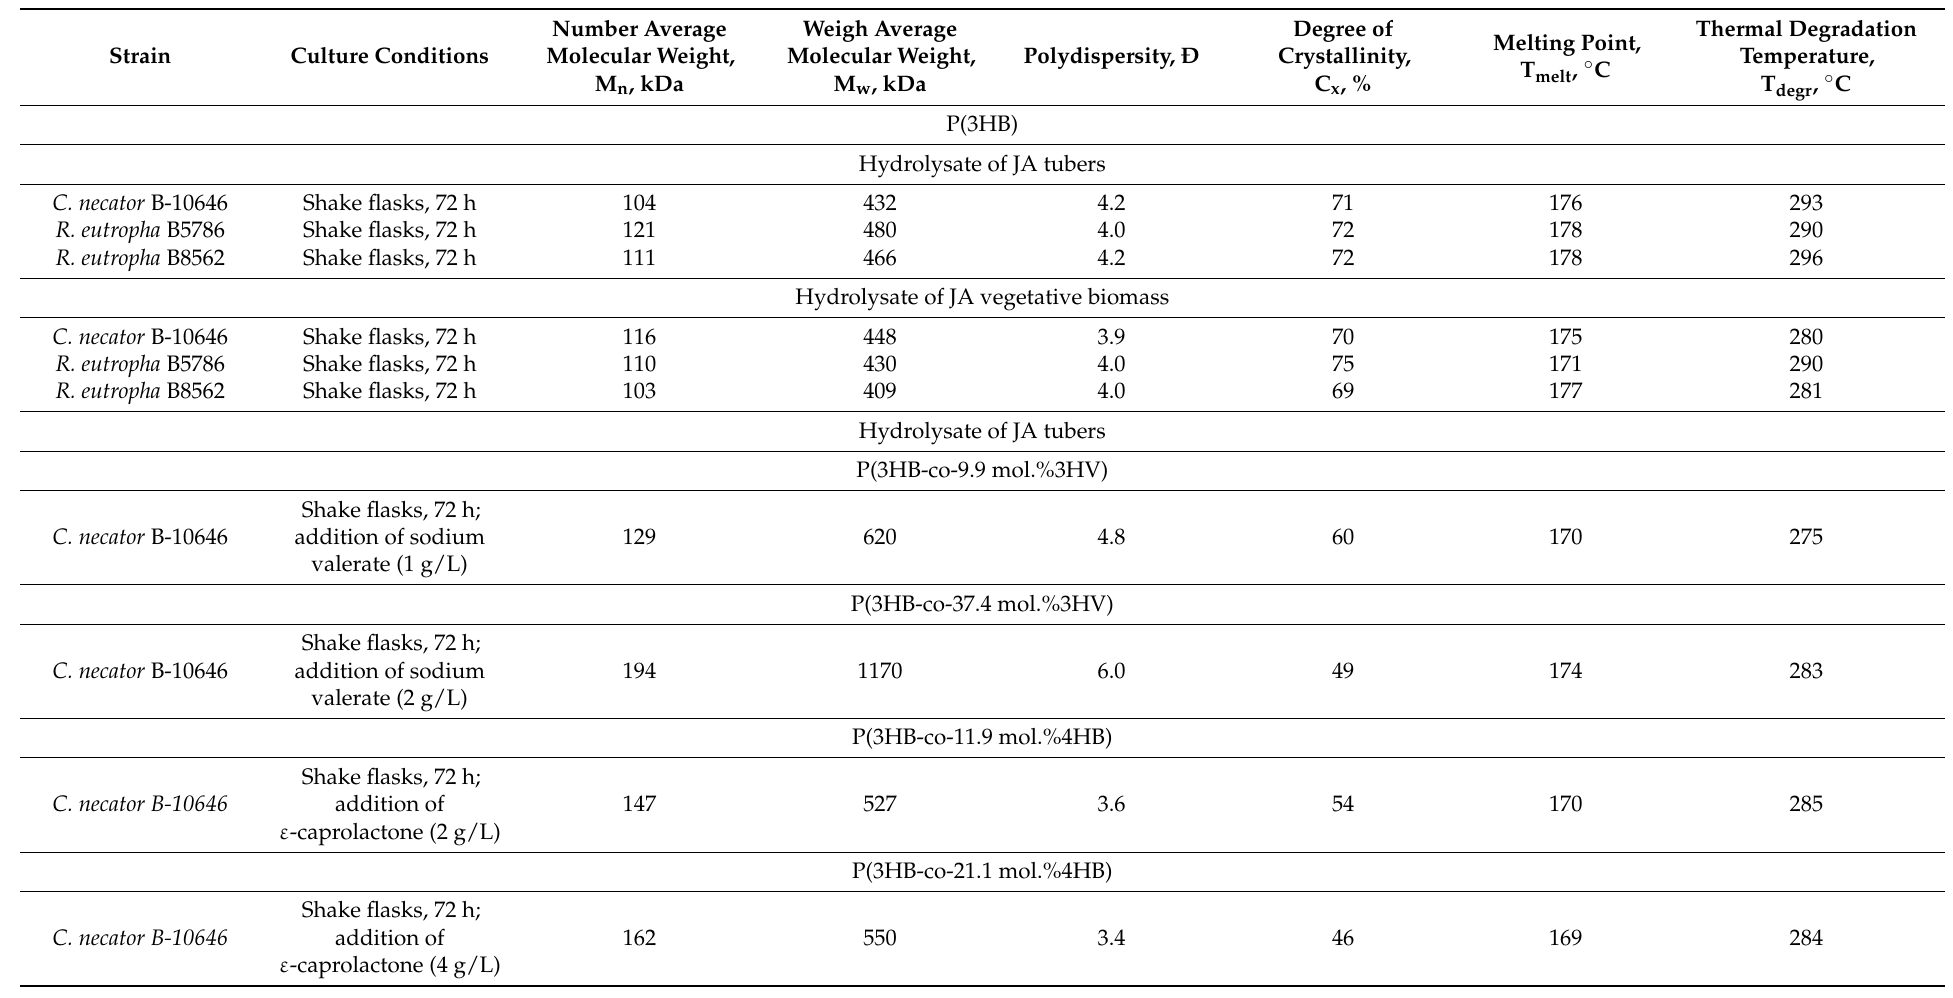
Table 5. Properties of P(3HB) homopolymer and PHA copolymers synthesized by C. necator B-10646, R. eutropha B5786 and B8562 from JA